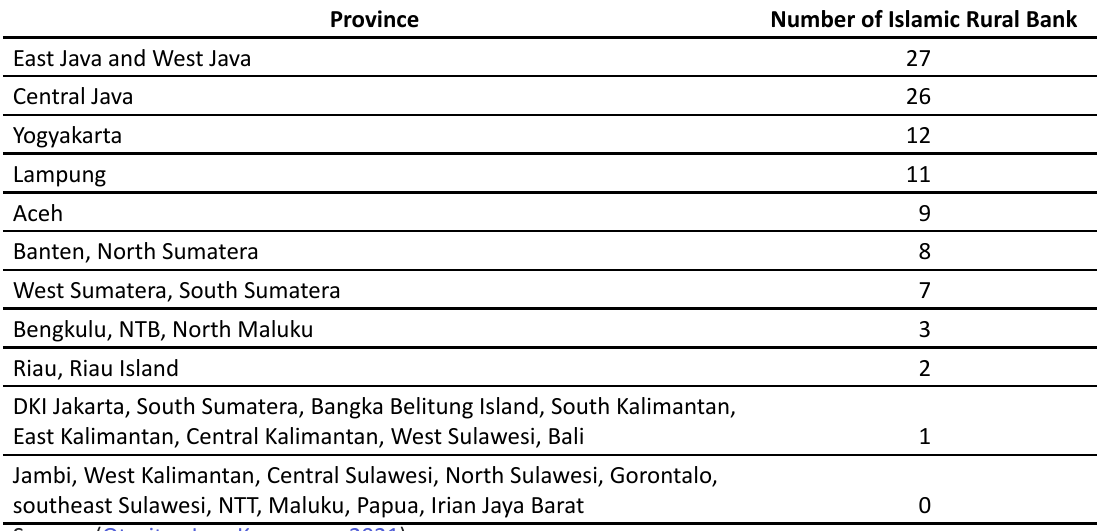
Table 1: Number of Islamic Rural Banks by